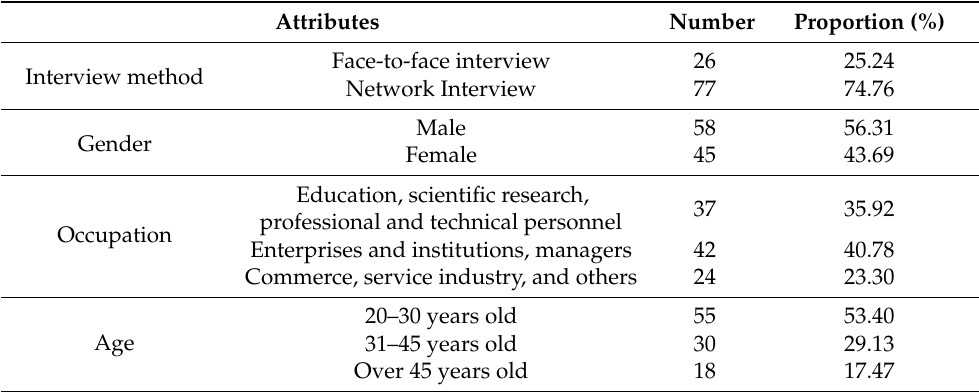
Table 2. Statistical information of